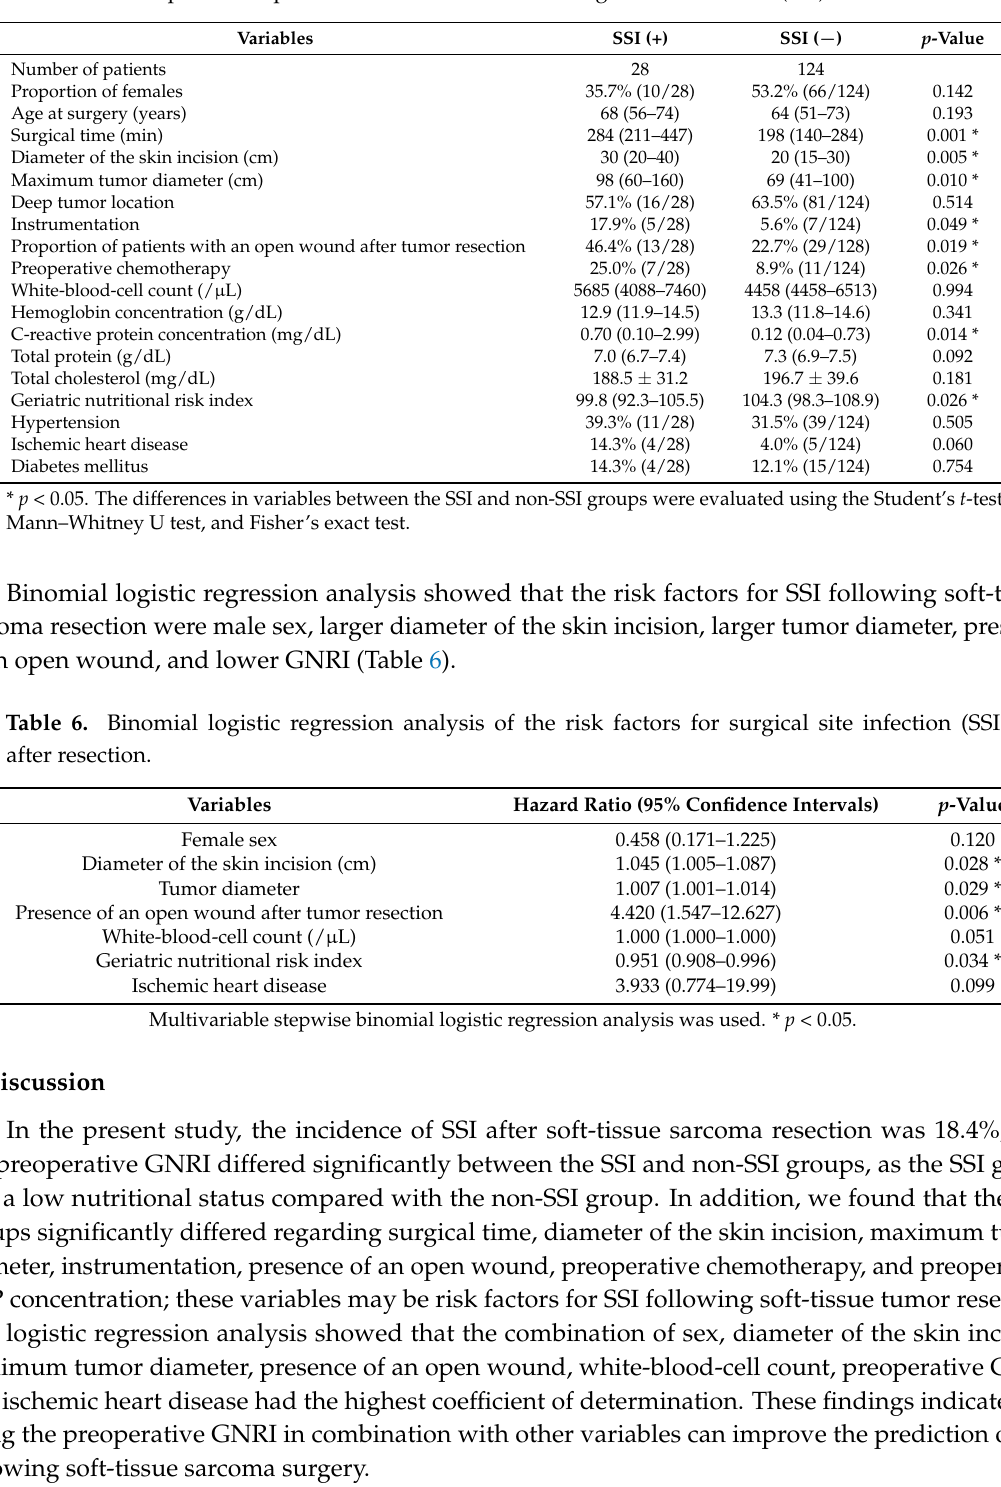
Table 5. Comparison of patients with versus without surgical site infection (SSI) after resection.